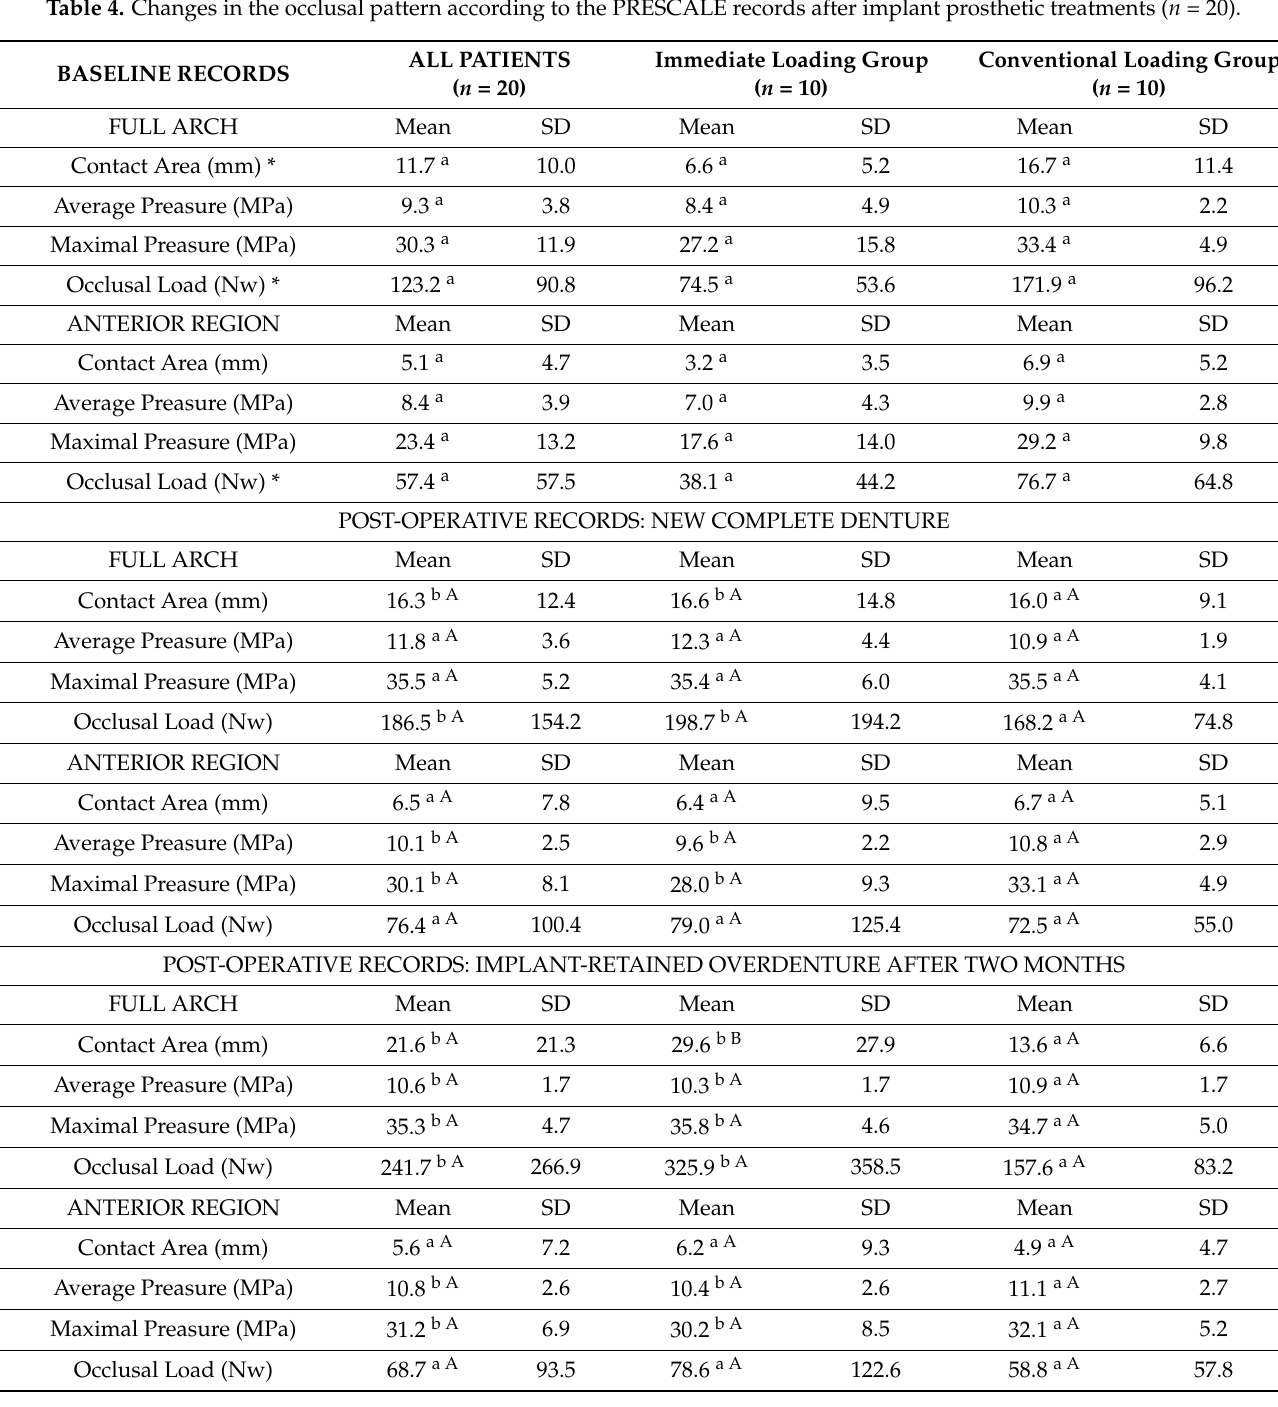
Table 4. Changes in the occlusal pattern according to the PRESCALE records after implant prosthetic treatments ( n =